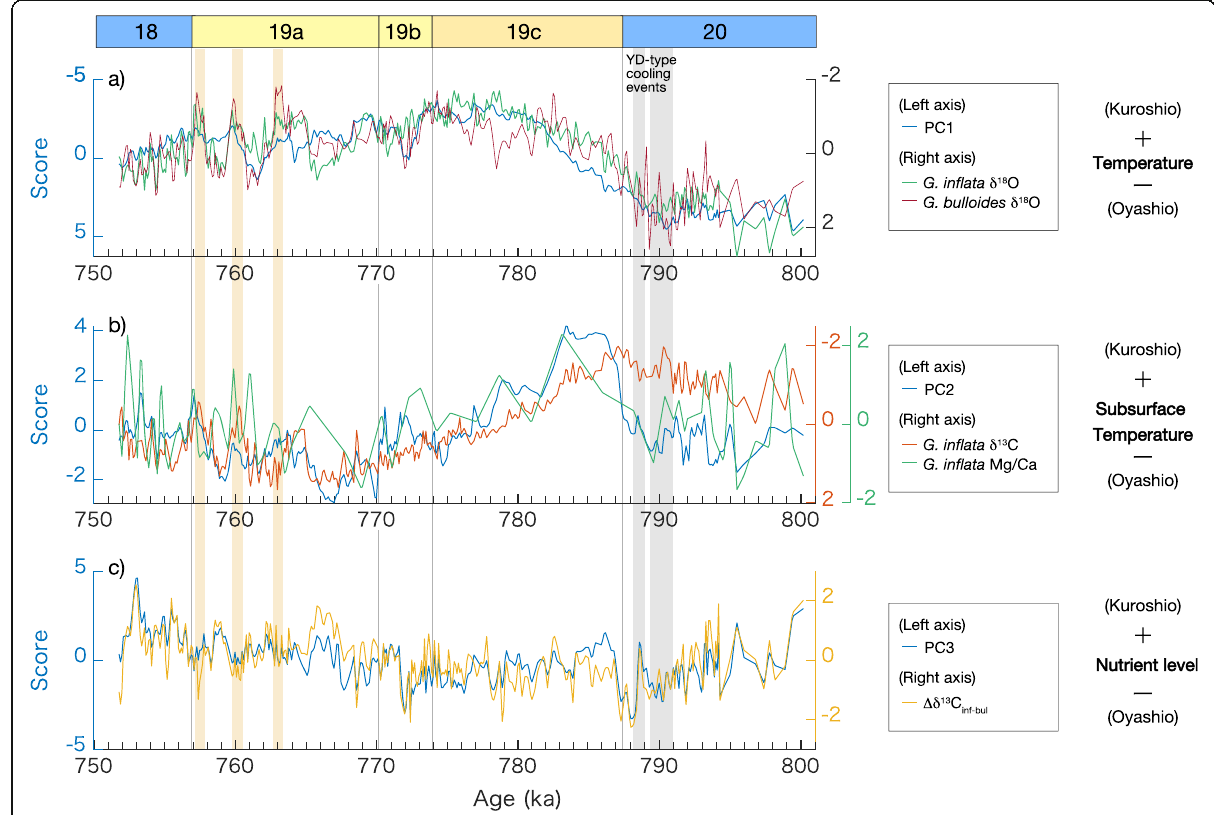
Fig. 3 Results of principal component analysis (PCA) compared to related geochemical proxies in the Chiba composite section, for a leading mode (PC1), b second mode (PC2), and c third mode (PC3). The geochemical proxies presented are standardized. Highlighted events are the same as for Fig.